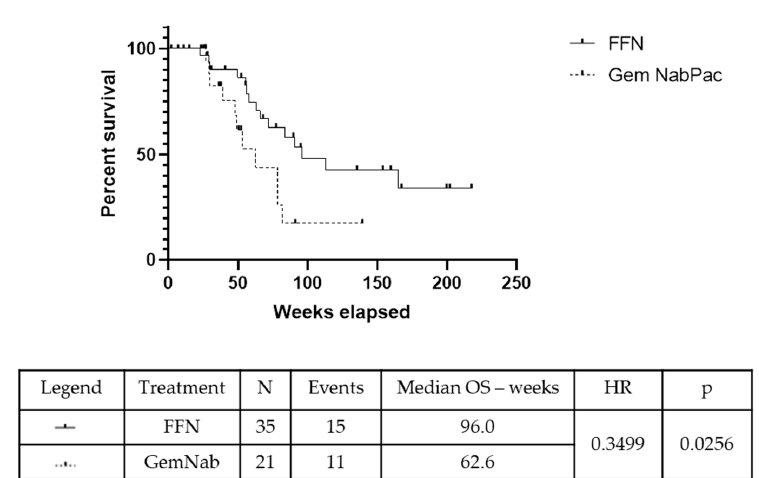
Figure 2. Kaplan-Meyer curve for OS in the overall population (OS pop) of patients treated with either FFN or GemNab. The median Overall Survival (mOS) in the overall population was 96 weeks in the FFN group and 62.6 weeks in the GemNab group ( p = 0.026, 95% CI 0.14–0.88; HR = 0.35).